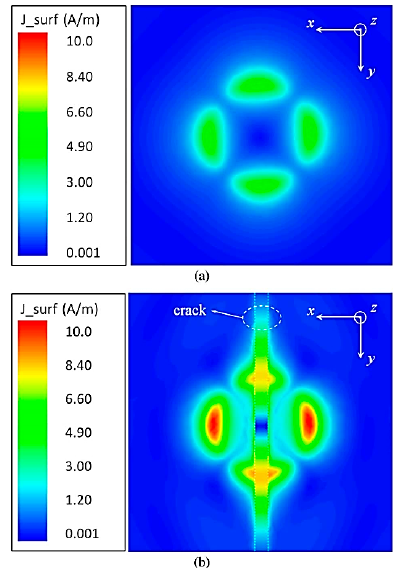
Figure 16. Distribution of the surface current on the aluminum board with/without a long crack. The operation frequency is 4.70 GHz. The distance between the aluminum board and loop is 5 mm. The width and depth of the crack are 5 and 10 mm, respectively. ( a ) Magnitude of the surface current without a crack; ( b ) magnitude of surface current with a crack (from [40]; copyright © IEEE 2014; reused with permission).